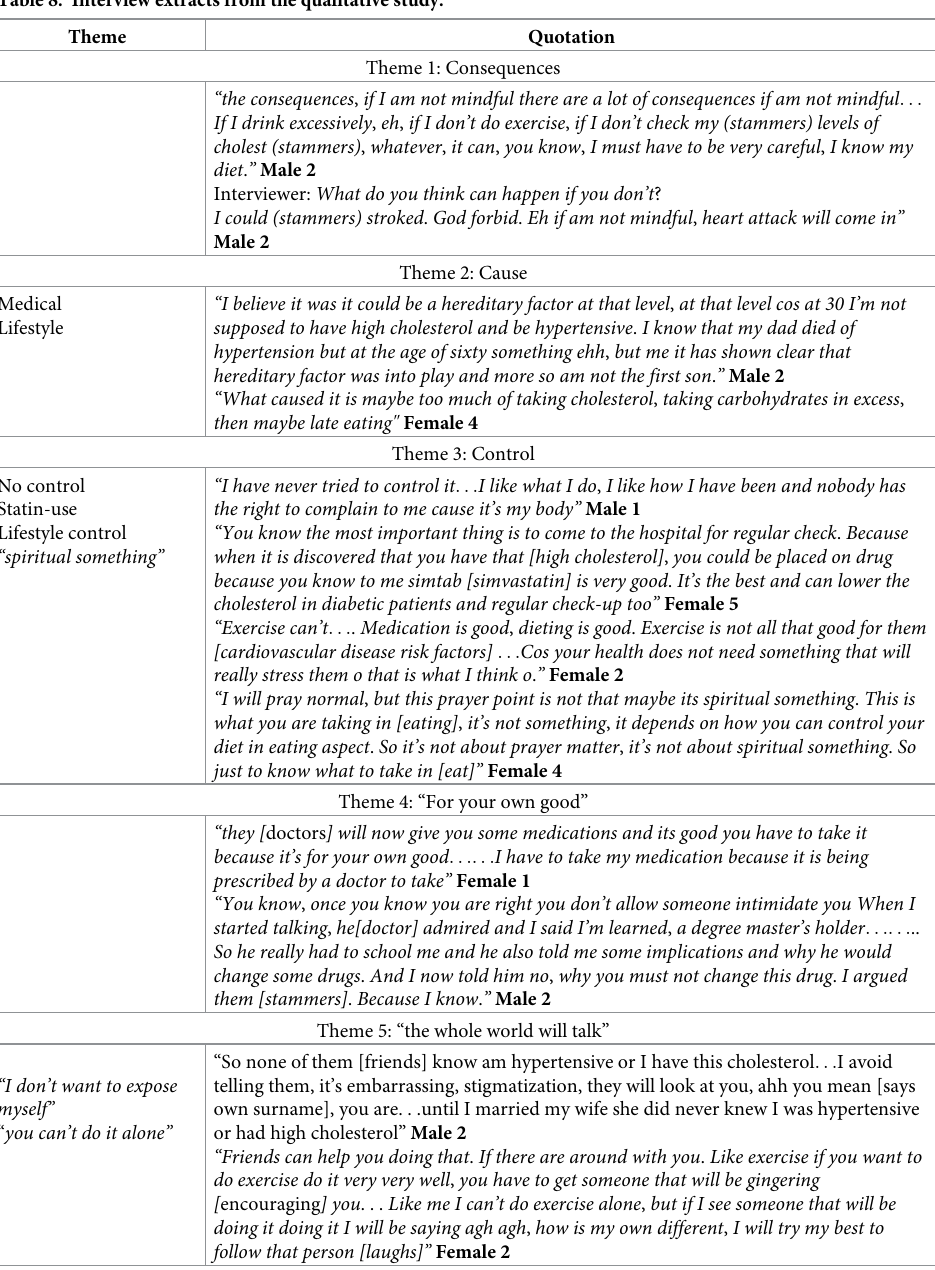
Table 8. Interview extracts from the qualitative